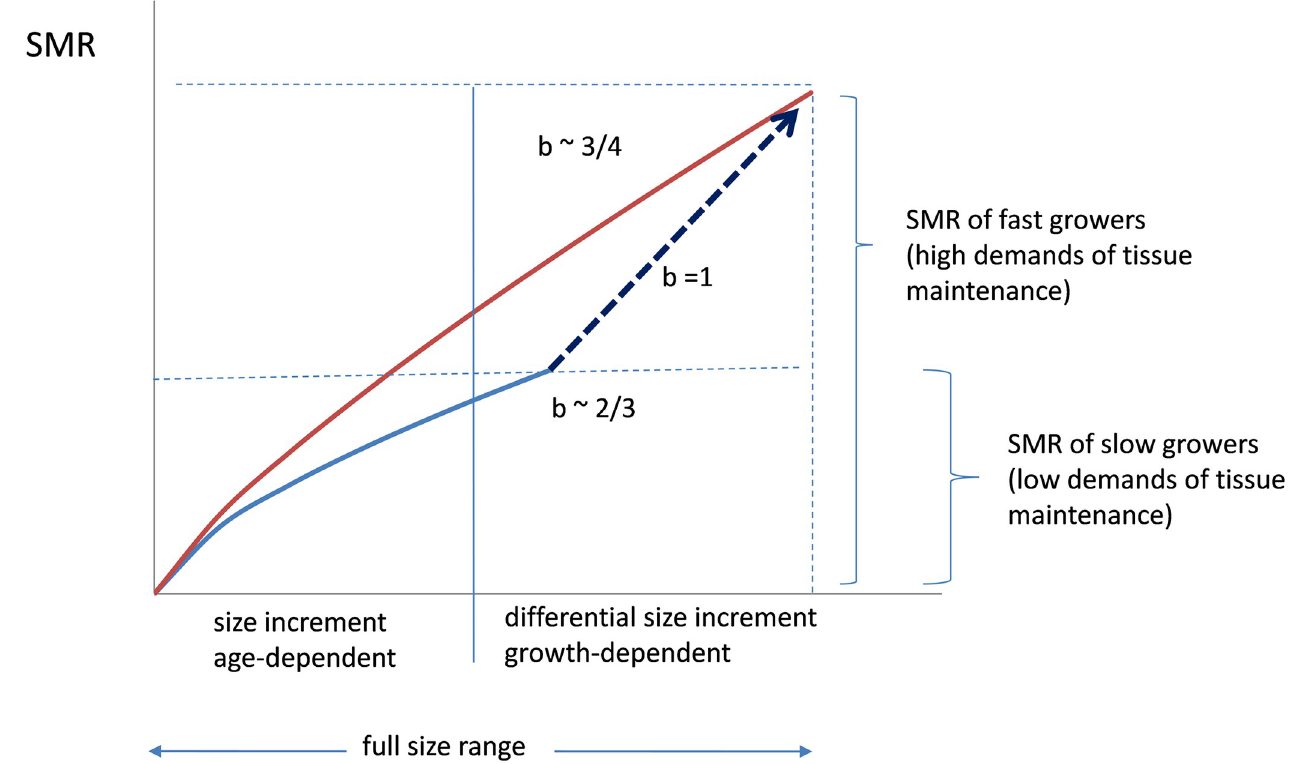
Fig 8. Proposed scheme accounting for a shift in the scaling exponent for the standard metabolic rate vs body size relationship, between slow growers (low maintenance demands) and fast growers (high maintenance demands). See text for details.